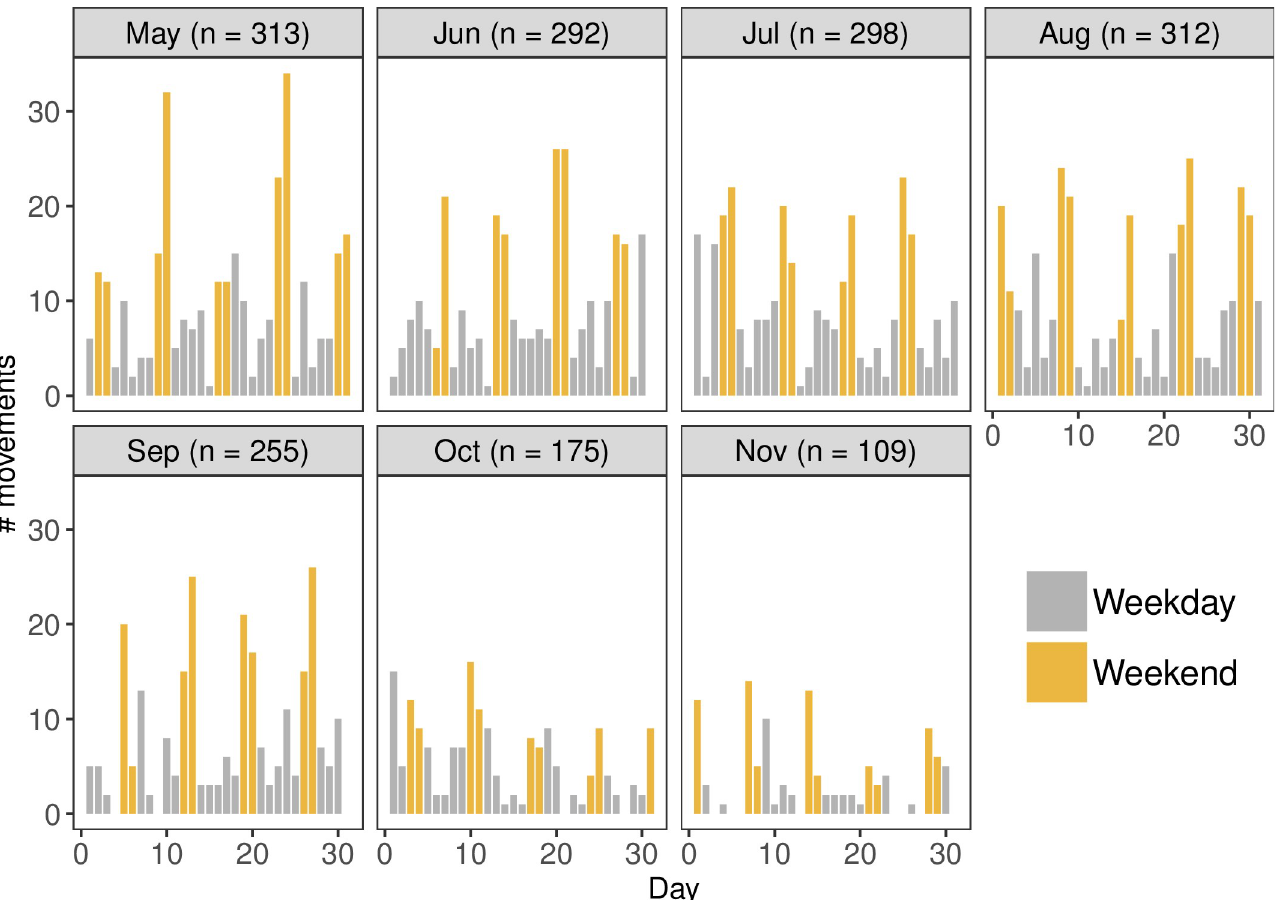
Fig 1. Number of daily movements of a sample of horses in Ontario, Canada between May and November 2015. The ‘n’ in each panel refers to the total number of horse movements during that month.